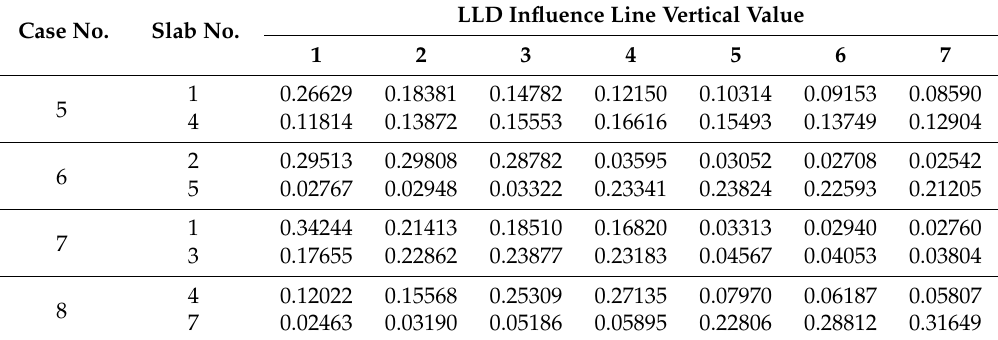
Table 8. LLD influence lines for damage cases listed in Table